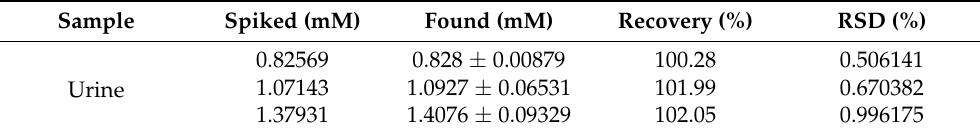
Table 2. Recovery of AA in human urine by Dy-OSCN/FTO photoelectric detection electrode. Sample